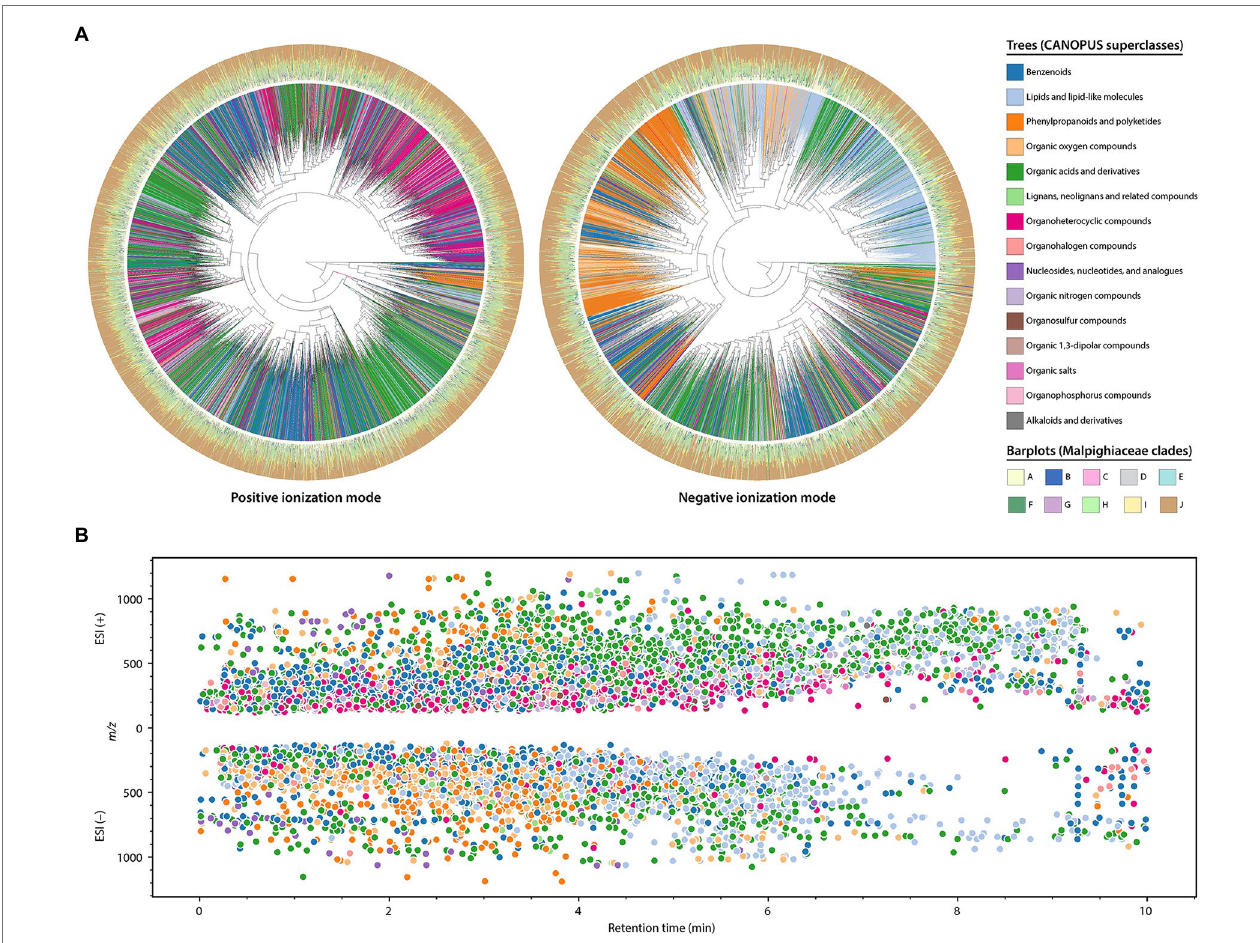
FIGURE 5 | In silico annotations obtained for the Malpighiaceae dataset from the Qemistree workflow combined with the CANOPUS classification tool. These are level 3 annotations according to the 2007 metabolomics standards initiative (Sumner et al., 2007). (A) Chemical hierarchies of the predicted molecular fingerprints from the Malpighiaceae plant samples analyzed in positive (left) and negative (right) ionization modes. The trees are pruned to keep fingerprints which were classified up to a superclass level in CANOPUS. The branch colors indicate the superclasses, while the barplots of the outer ring indicate the relative abundance of